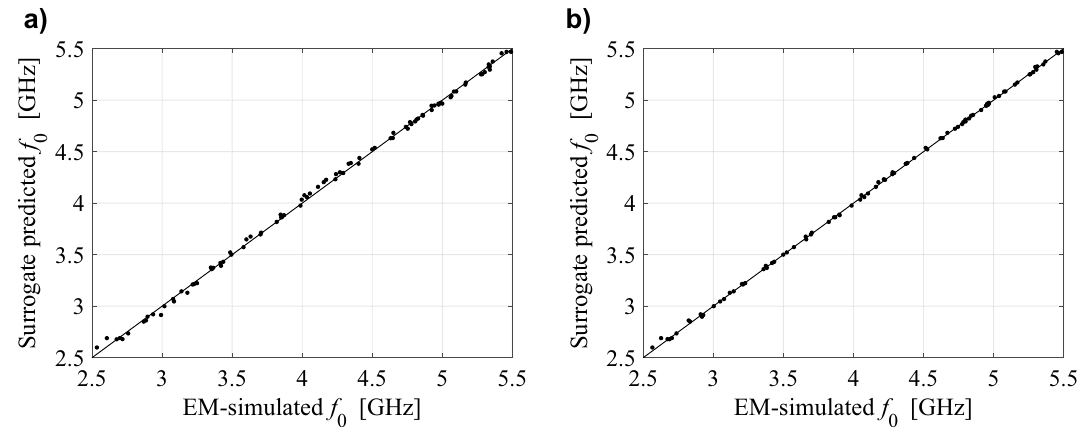
Figure 5. Ring-slot antenna of Fig. 4a: scatter plots of the center frequency f 0 [GHz] yielded by the proposed surrogate against their EM-simulated counterparts; surrogates constructed using ( a ) N B = 20 and ( b ) N B = 100 samples.